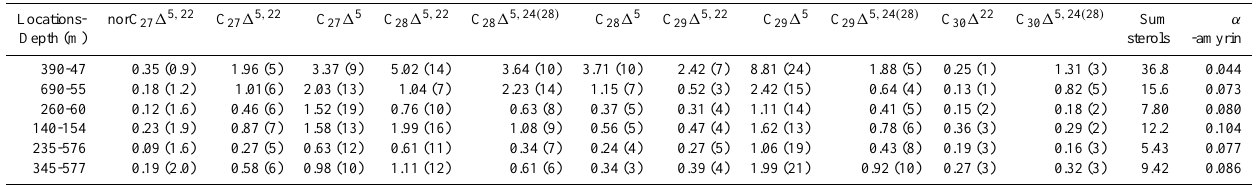
Table 8. Concentrations of sterols in sediments from the Beaufort Sea (µgg − 1 ). Percentage of total sterols is given in brackets. Locations- norC 27 1 5 , 22 C 27 1 5 ,